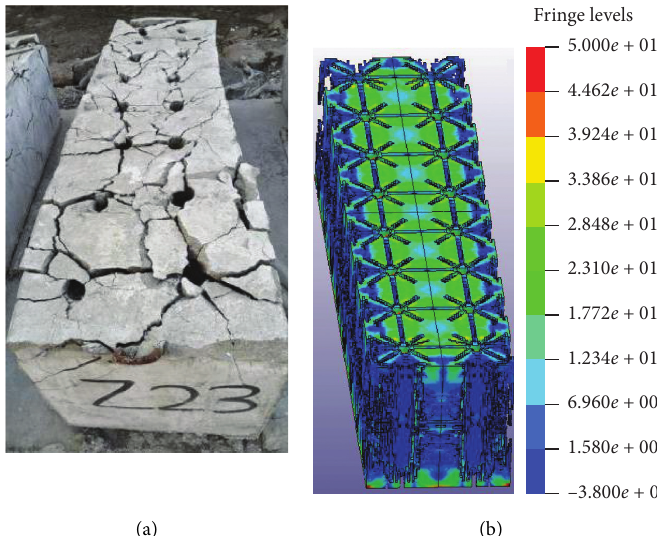
Figure 7: Comparison of experimental results and simulation results for a concrete column. (a) The test result. (b) The simulation